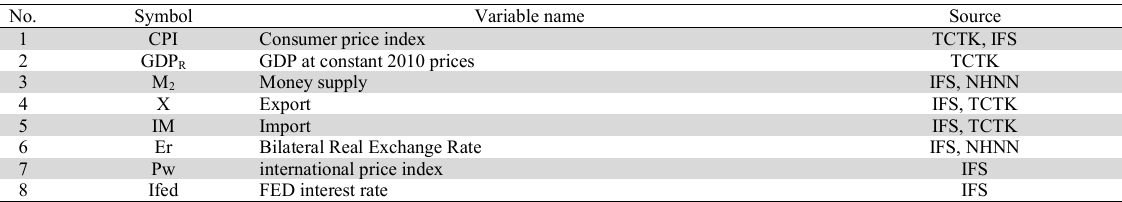
The results in Table 2 show that the discrepancies of DLCPI, DLGDP, DLM 2 , DLX, DLIM, DLER, DLPW, DLIFED